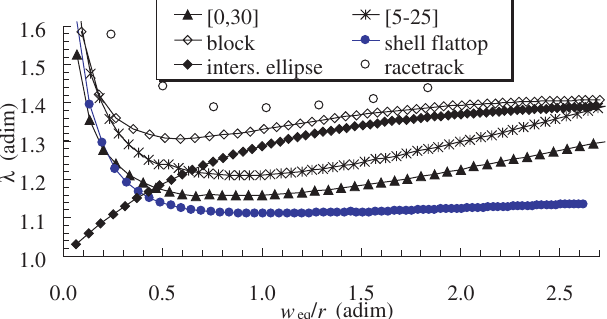
FIG. 20. (Color) Numerical evaluation of the parameter (cid:8) versus equivalent sector width (41) in four different coil layouts with an aperture radius of 30 mm.